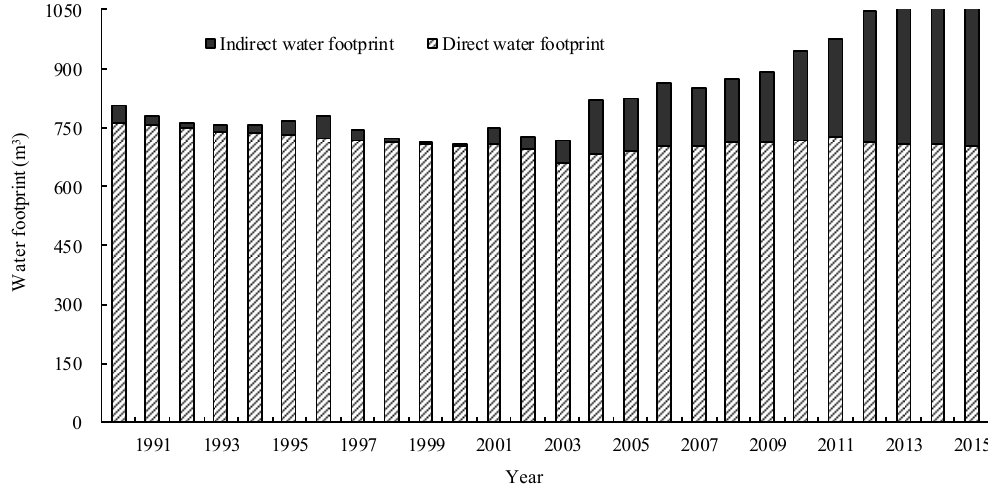
Figure 6. Dynamic changes of the water footprint.